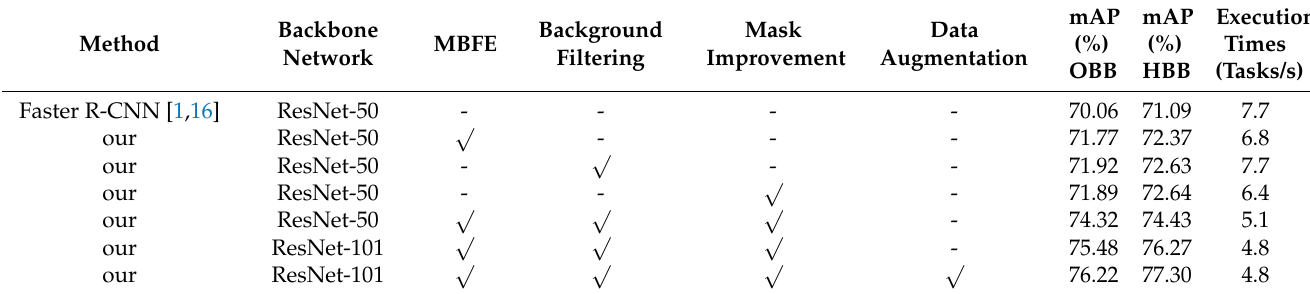
Table 1. Ablation experiment of the components on the DOTA v1.0